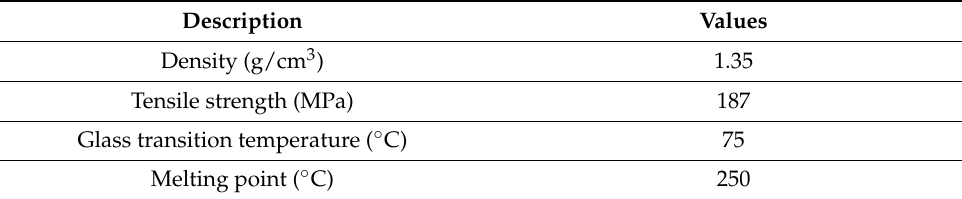
Table 1. Properties of waste PET (obtained from supplier).